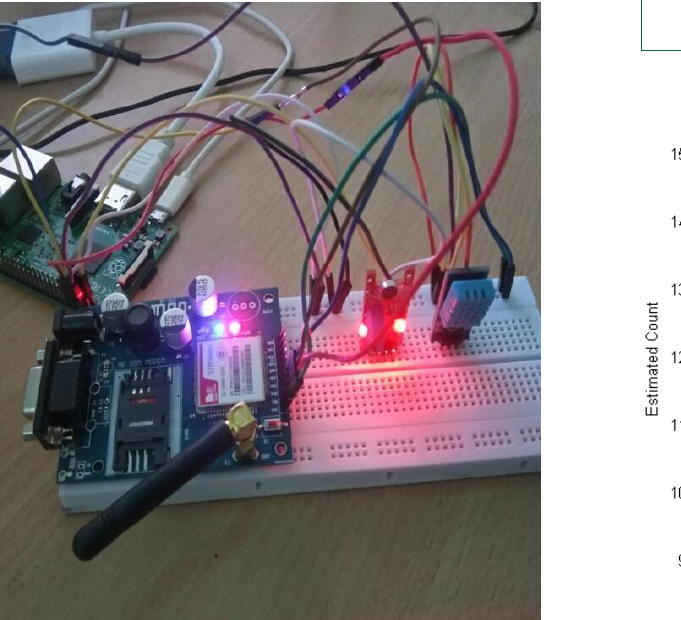
Figure 10: Plotting of exact counts over a group of 11